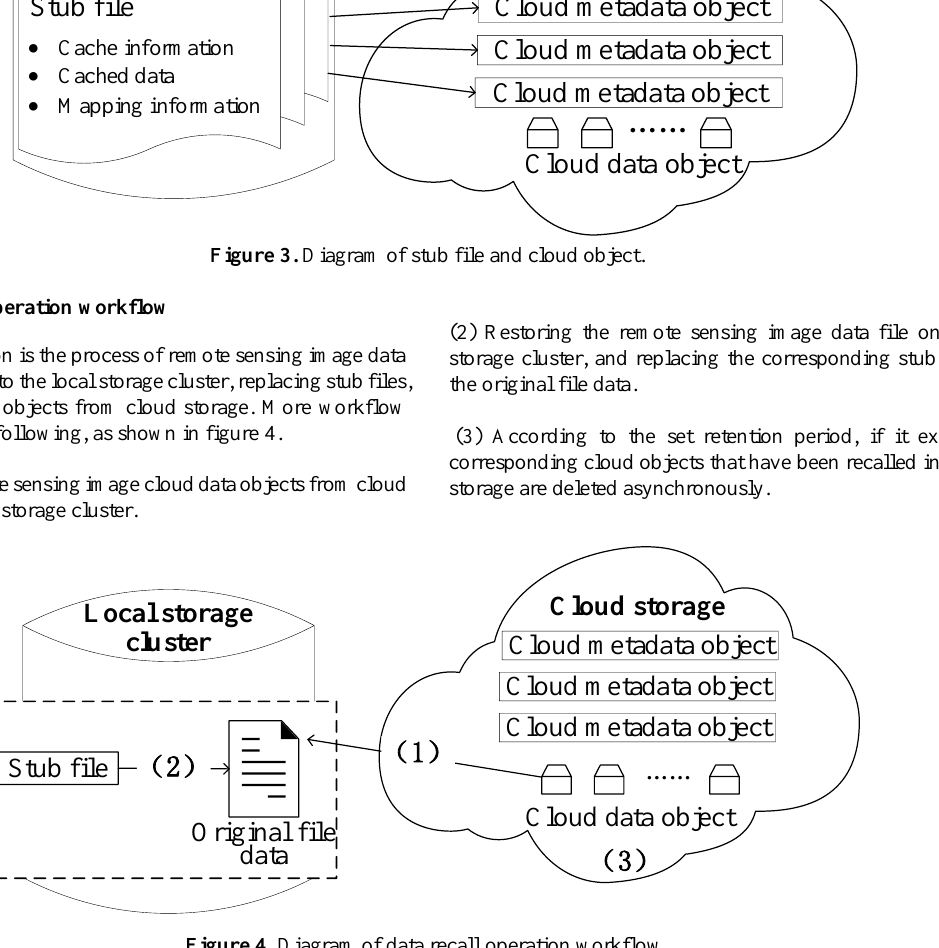
Figure 4. Diagram of data recall operation